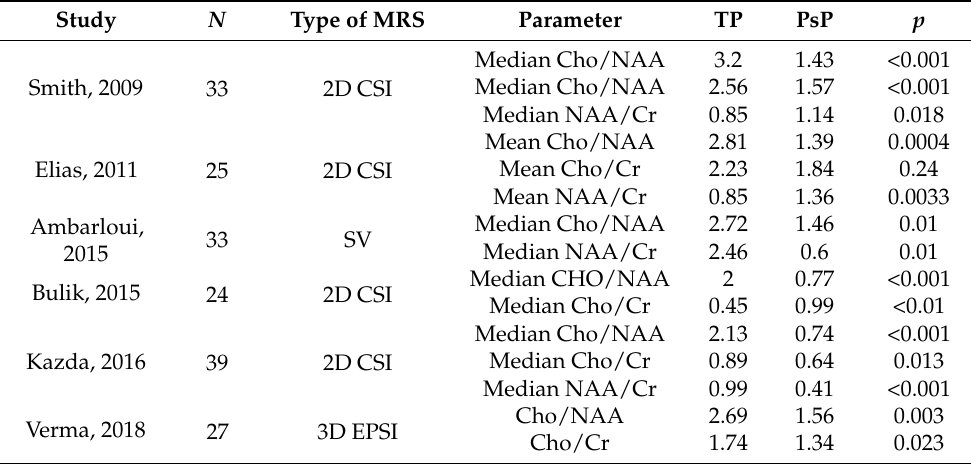
Table 3. Review of studies of magnetic resonance spectroscopic imaging. N = number of patients, TP = True